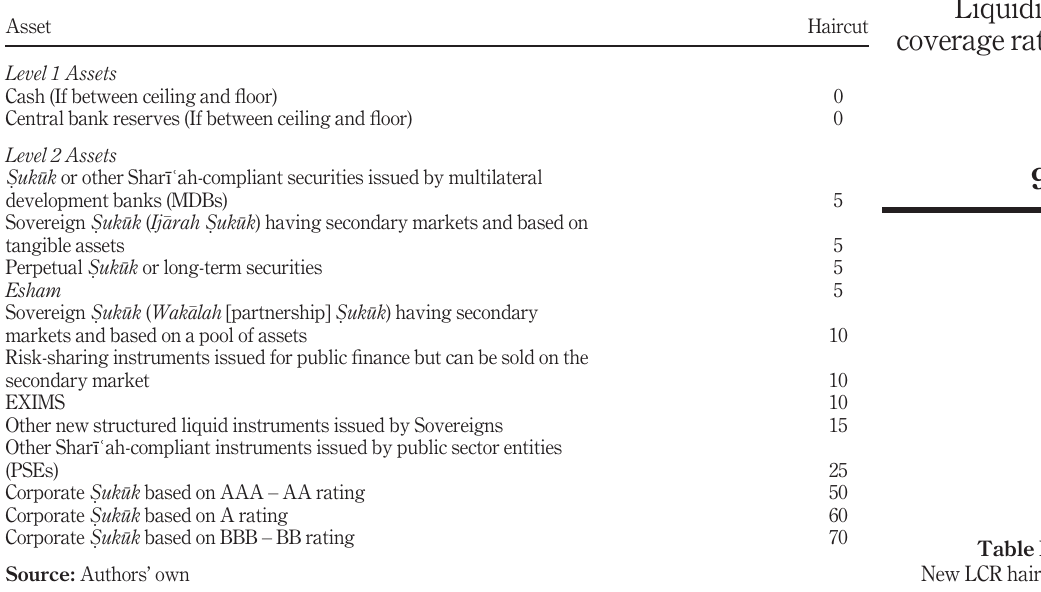
Table III. New LCR